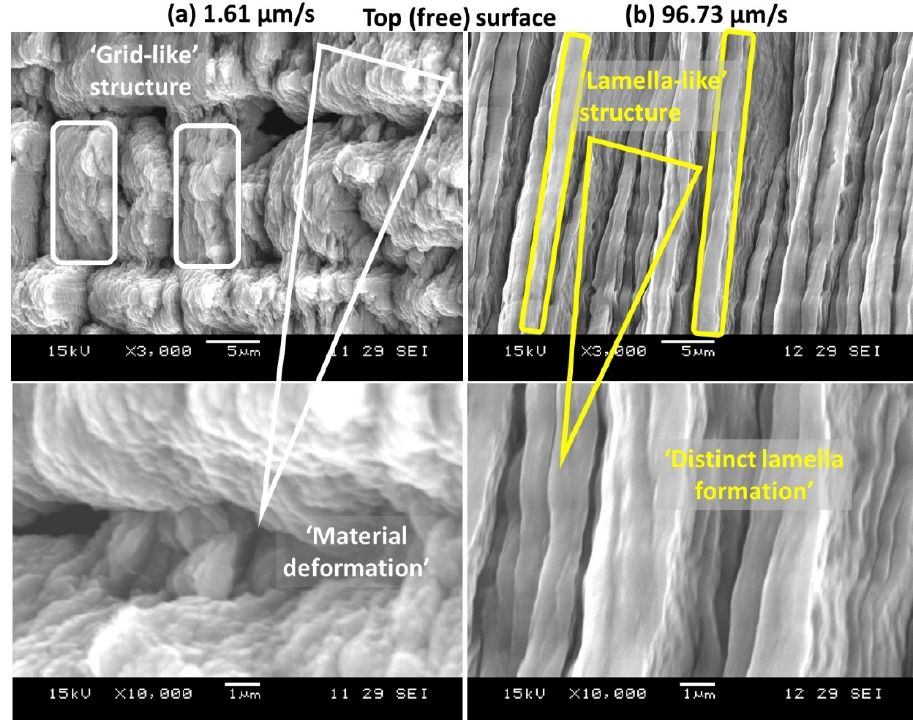
Figure 5. Free ( top ) surface of the Al alloy microchips noticed in SEM image analysis.